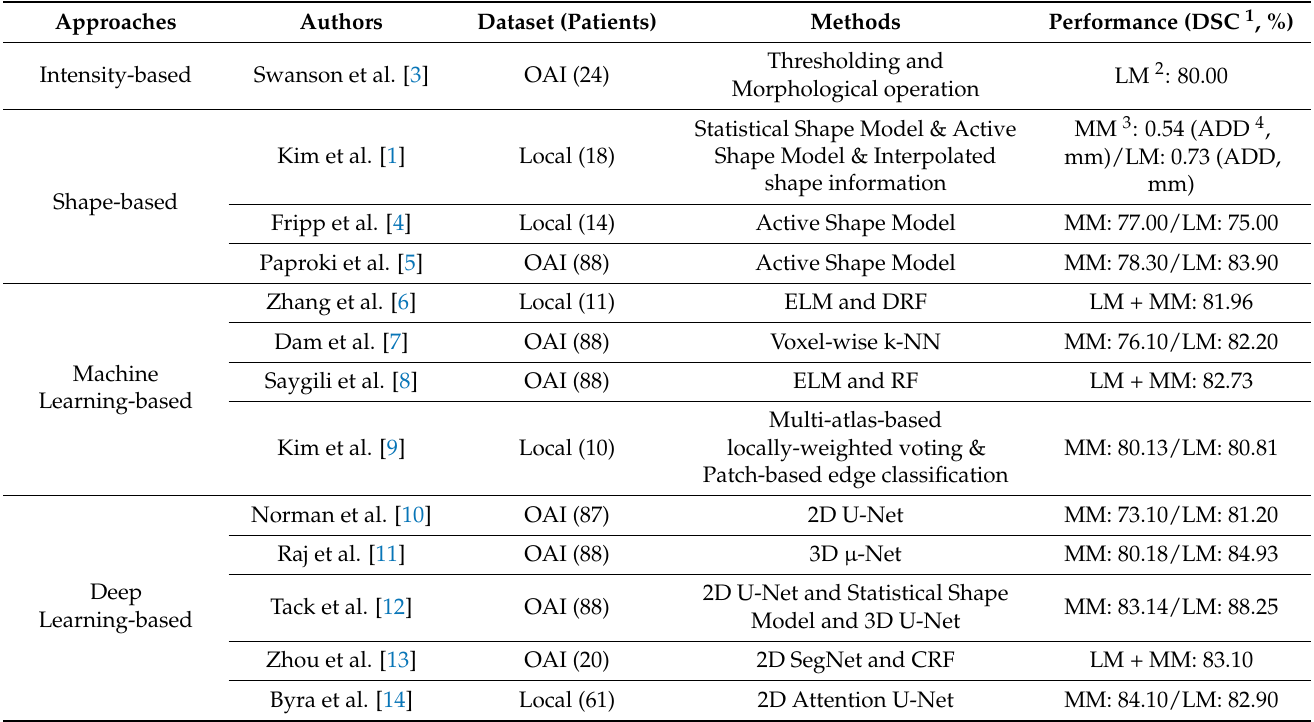
Table 1. Related works of meniscus